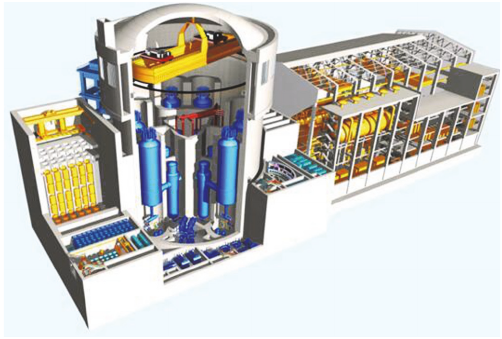
Figure 2: HTR-PM plant building cross section 3D view.